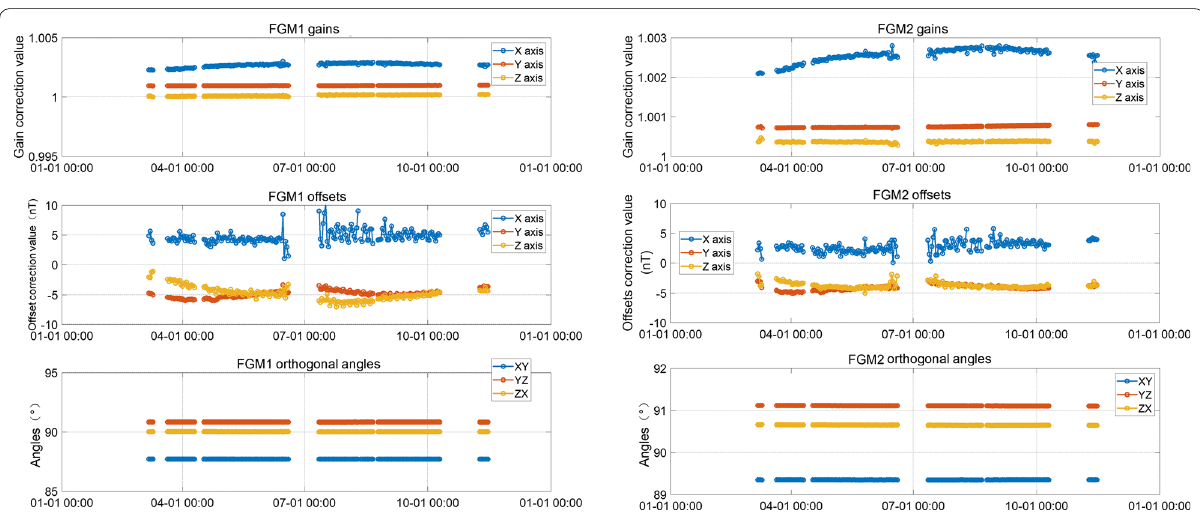
Fig. 13 Time variations of FGM1 and FGM2 linear parameters, gain factors, offsets, and orthogonal angles from March 7th, 2018 to November